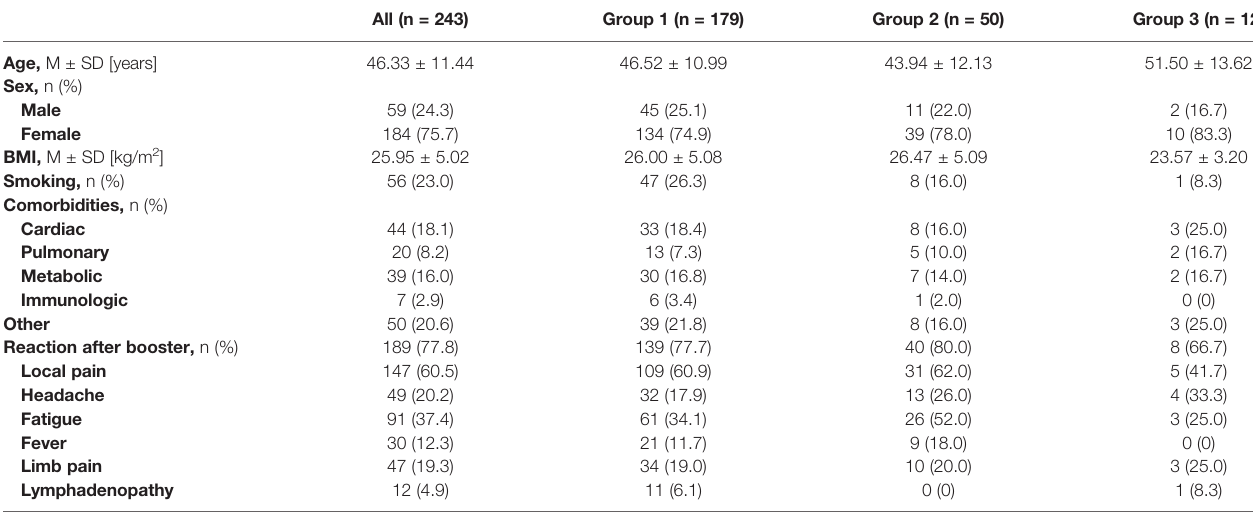
TABLE 1 | Characteristics of the study cohort (n =